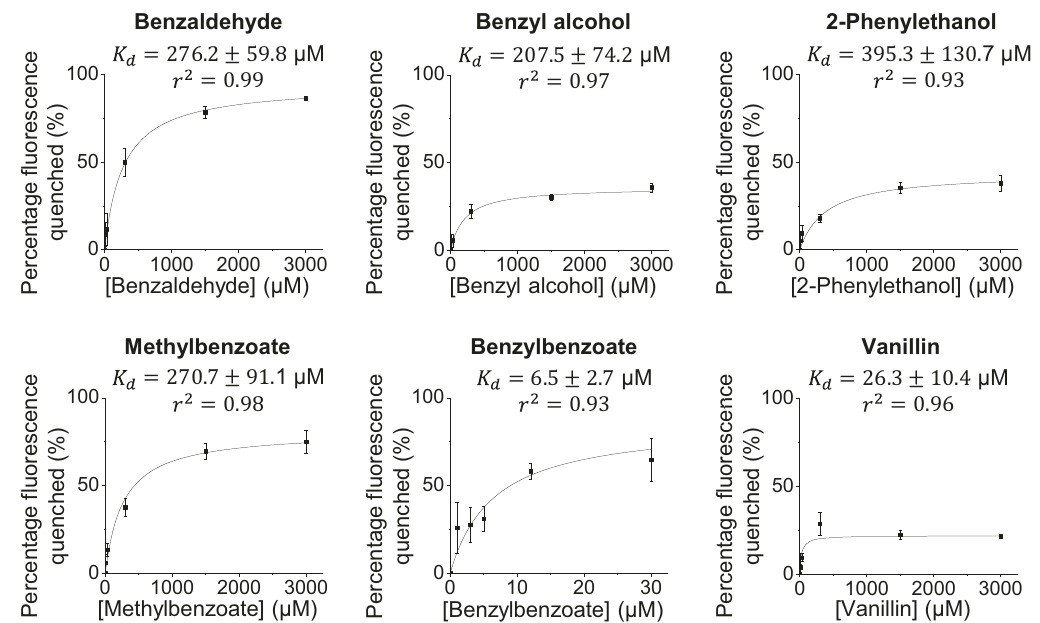
Fig. 5 | Binding kinetics of recombinant PhnsLTP3 with VOCs emitted by pet- unia fl owers. TNS displacement assays were performed at fi xed concentrations of PhnsLTP3(1 µ M)andTNS(3 µ M)andthe fl uorescencewasmeasuredbeforeandafter the tested compounds were added at various concentrations. The results are expressed as percentage of fl uorescence quenched with respect to the